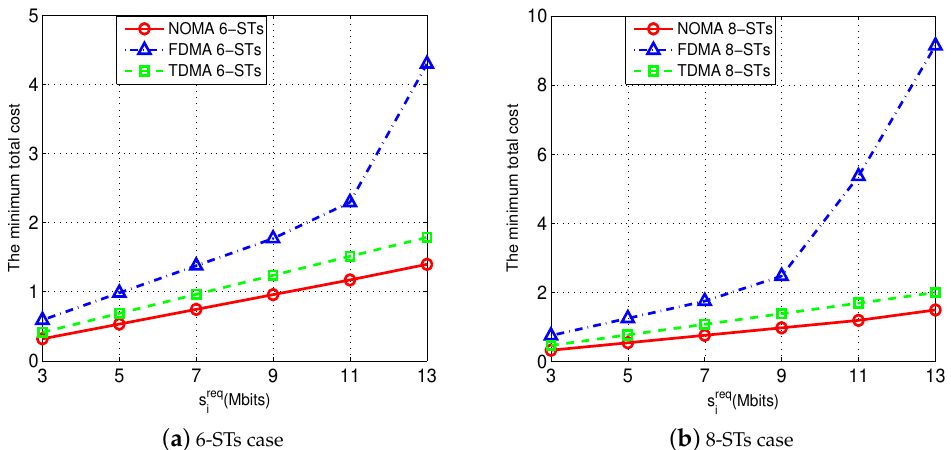
Figure 7. Performance of our proposed NOMA-transmission scheme in comparison with the FDMA scheme and TDMA scheme.